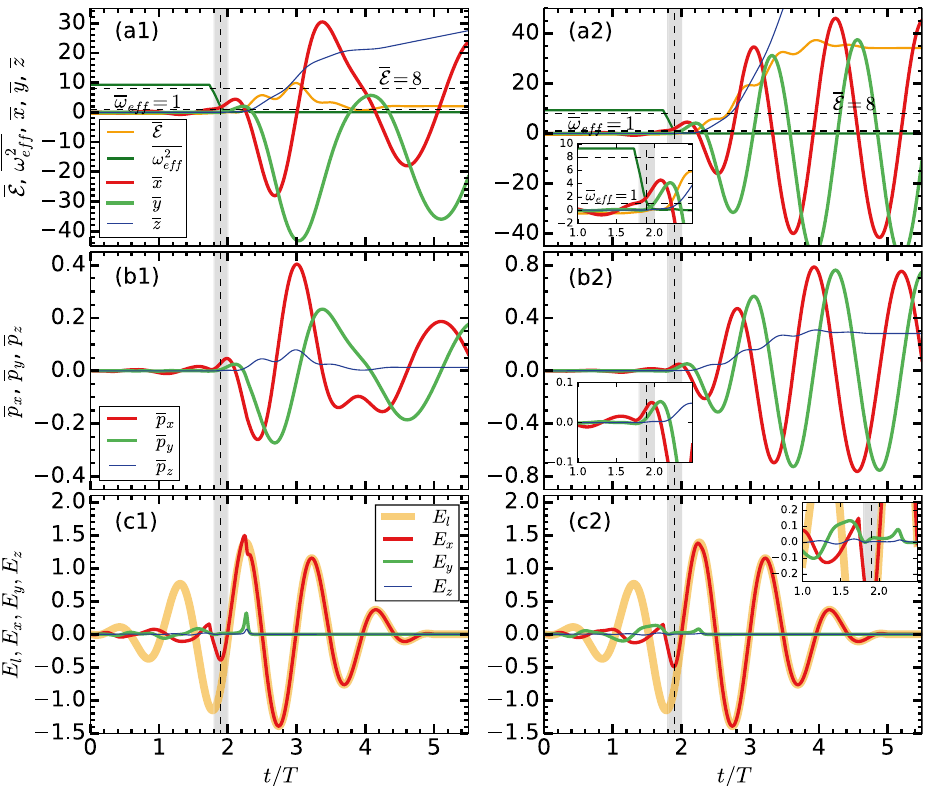
Figure 2. Modified RSM results with ( E l , B l ) and B ext along z : showing dynamical variables of the same 0.028, 0.0569 a.u. electron as in Fig. 1. Panels in the left ( a1,b1,c1 ) and right ( a2,b2,c2 ) columns are with B ext ≈ 0.5 and resonant � c 0 /ω 1 (ECR case) respectively. In the ECR case corresponding to non-resonant � c 0 /ω = = E (τ) 1.85 , and E A reaches up to E (τ) 36 compared to E A 2.1 in AHR occurs little early around t / T ≈ ≈ = ≈ Fig. 1a2; corresponding momenta and excursion also significantly vary after the electron is freed via AHR near 1.85 . Inset plots (in a2,b2,c2 ) show zoomed view of dynamical variables near AHR and inside the cluster t / T ≈ due to strong B ext . Other laser and cluster parameters are as in Fig.